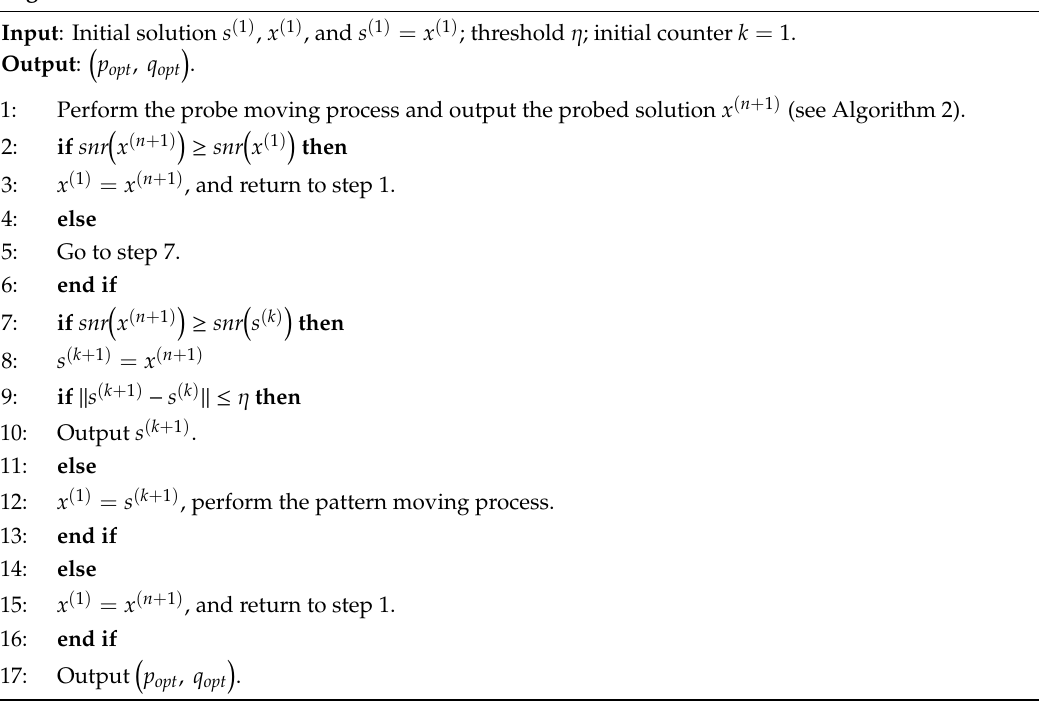
Algorithm 1. Rosenbrock